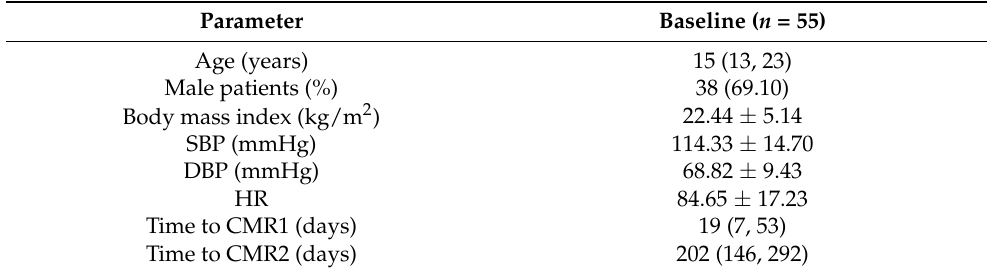
Table 1. Clinical characteristics of patients at